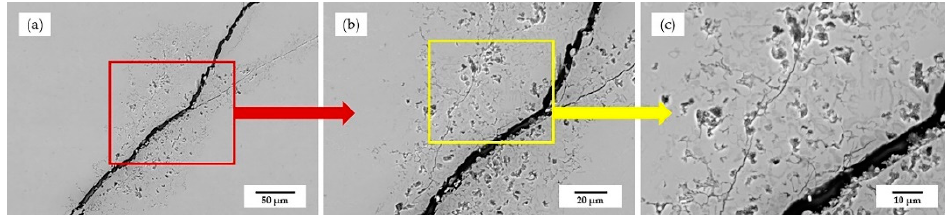
Figure 18. Corrosion morphologies of the 55NiTi coating: ( a ) full view of the corrosion initiation at a crack area; ( b ) the middle of the corrosion area; ( c ) the edge of the corrosion area.